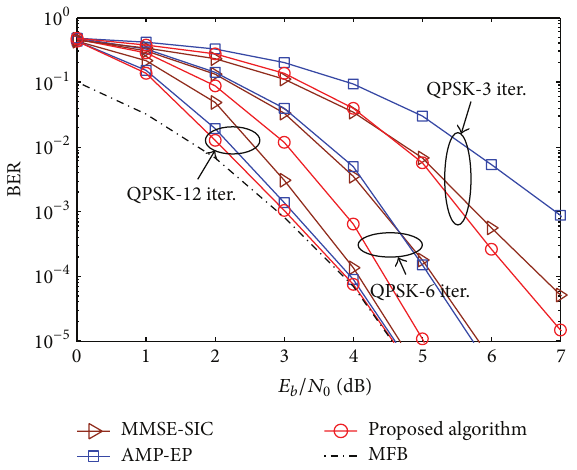
Figure 10: BER performance for different detection algorithms in a 64 × 64 MIMO system, with QPSK modulation and ITU-EVA channel.